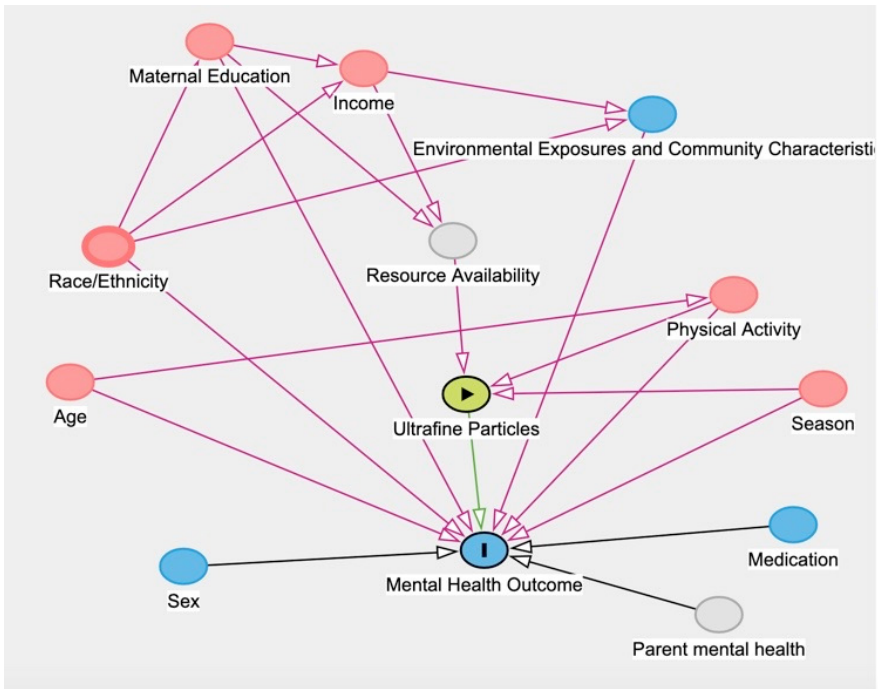
Figure 1. Directed Acyclic Graph (DAG) quantifying the relationship between UFPs and PROMIS domain T scores including confounding pathways.